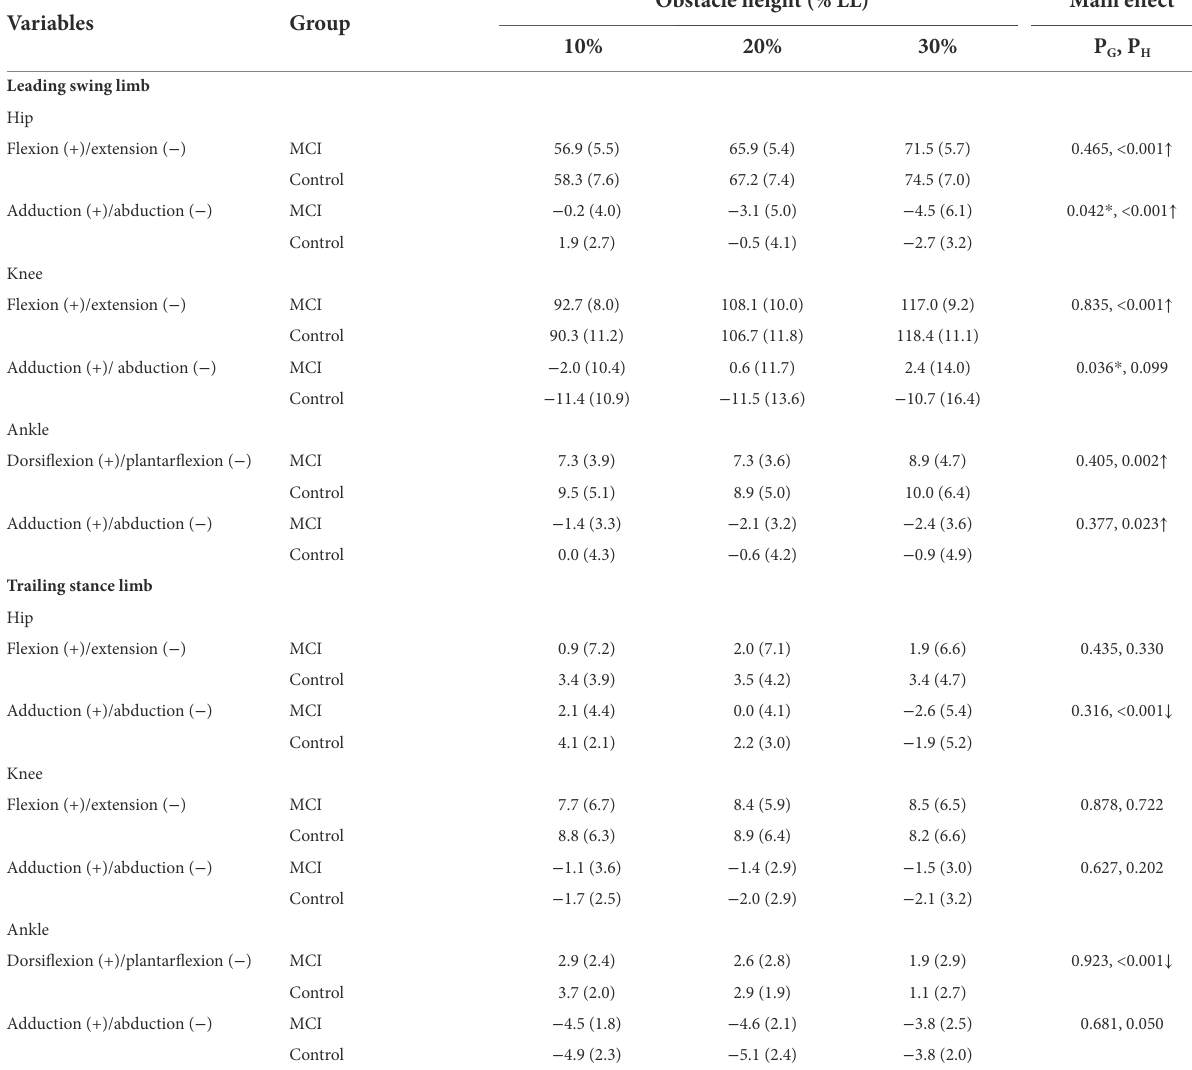
TABLE 4 Means (standard deviations) of the crossing angles of the hip, knee, and ankle joints of the leading swing limb and trailing stance limb in the patients with mild cognitive impairment (MCI) and healthy controls (Control) when the leading toe was above the obstacle of heights of 10, 20 and 30% of the subject’s leg length